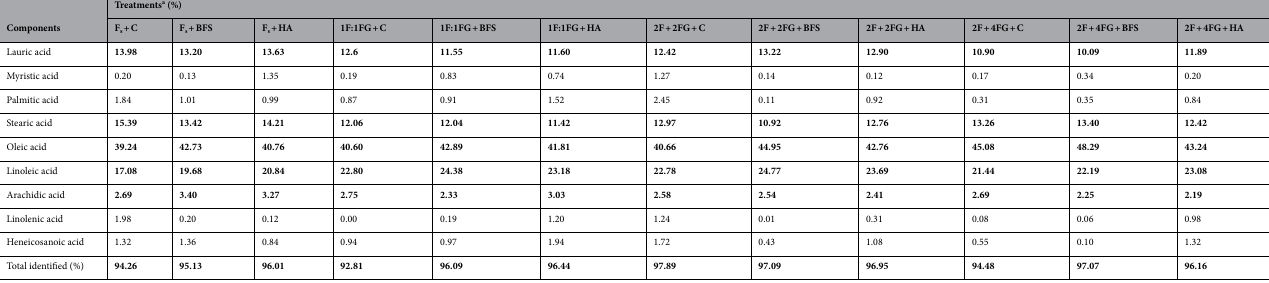
Table 4. Proportion of fennel oil constituents under different cropping patterns and fertilization. The main components are shown in bold. a C (control), BFS (biofertilizers), HA (humic acid), and Fs (fennel sole cropping), 1F:2FG, 2F:2FG, and 2F:4FG are the ratios of fennel and fenugreek in the intercropping patterns.